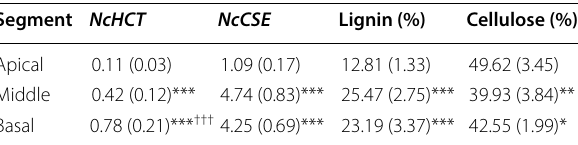
Table 1 Expression levels of NcCSE and NcHCT , and lignin and cellulose contents, in apical, middle and basal stem segments